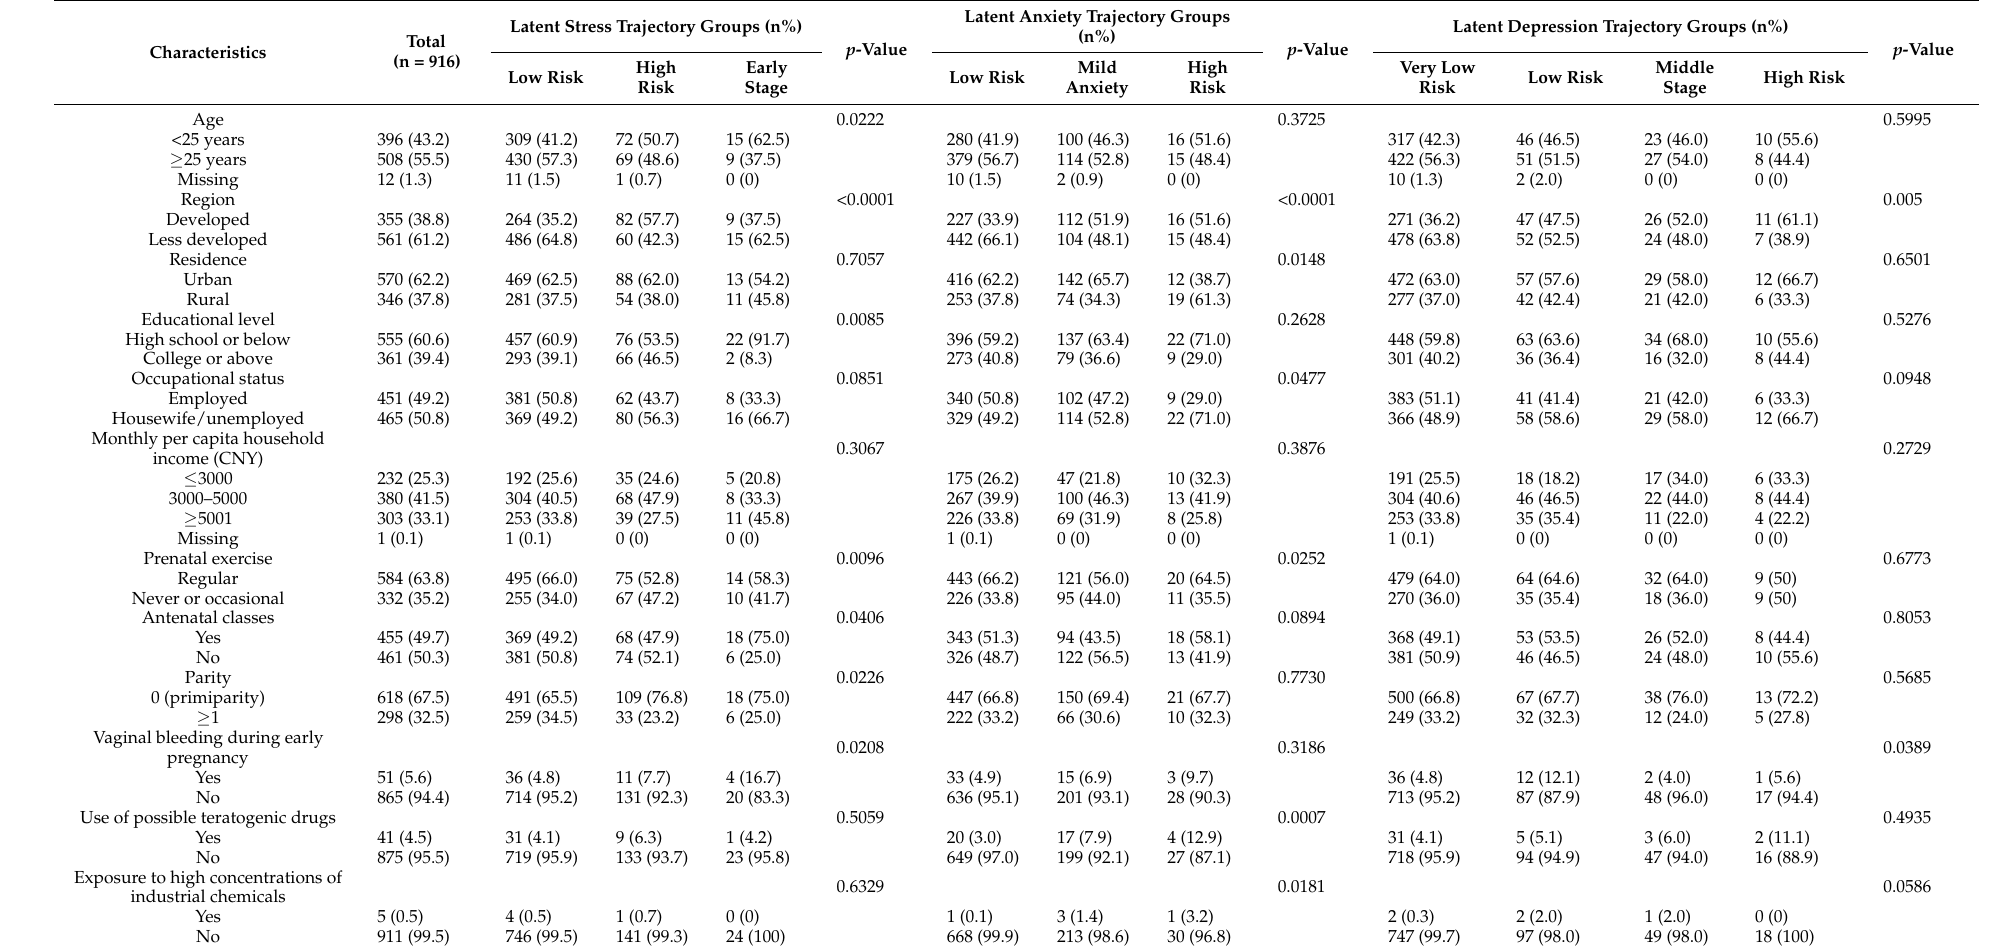
Table 4. Characteristics of and correlations for stress, anxiety, and depression trajectory